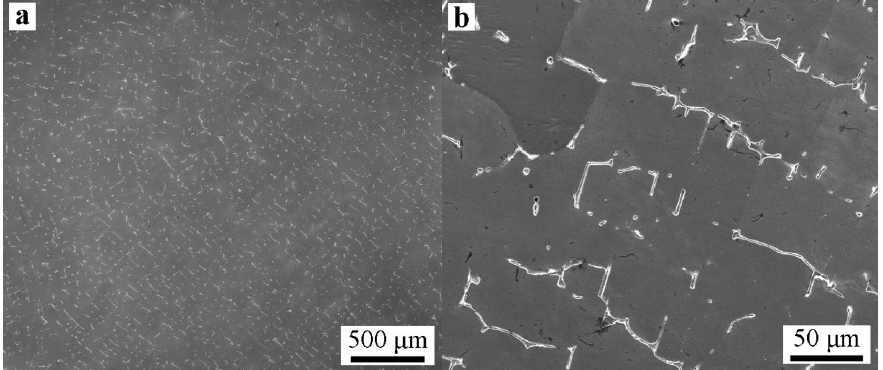
Figure 6. Scanning electron microscopy (SEM) ( a ) low magnification and ( b ) high magnification micrographs of interdendritic segregation in the ESR ingot.